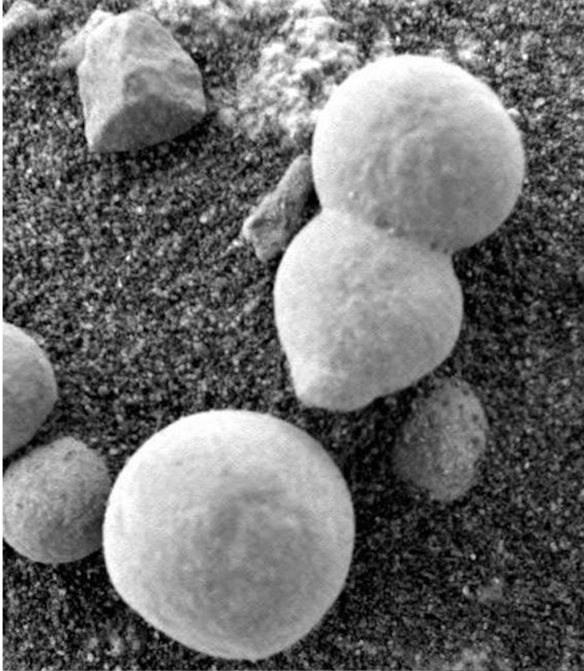
Figure 7. Mars. Sol 182. A majority of experts identified these spec- imens as basidiomycota: fungal "puffballs" (Joseph 2016). Note what appears to be spores littering the surface. (Reproduced with permission from Joseph et al. 2019).